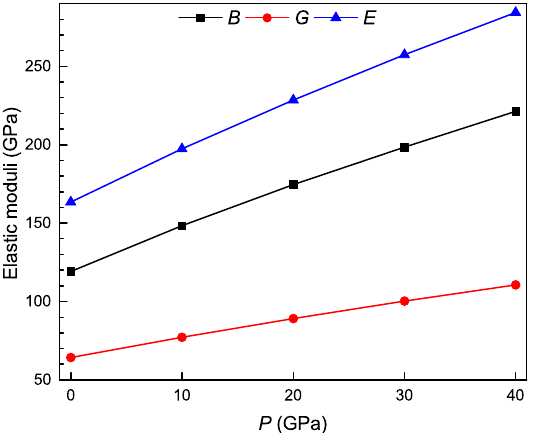
Figure 5. Bulk ( B ), shear ( G ) and Young’s ( E ) moduli as a function of pressure for the Ti 4 Nb 3 Al 9 phase.